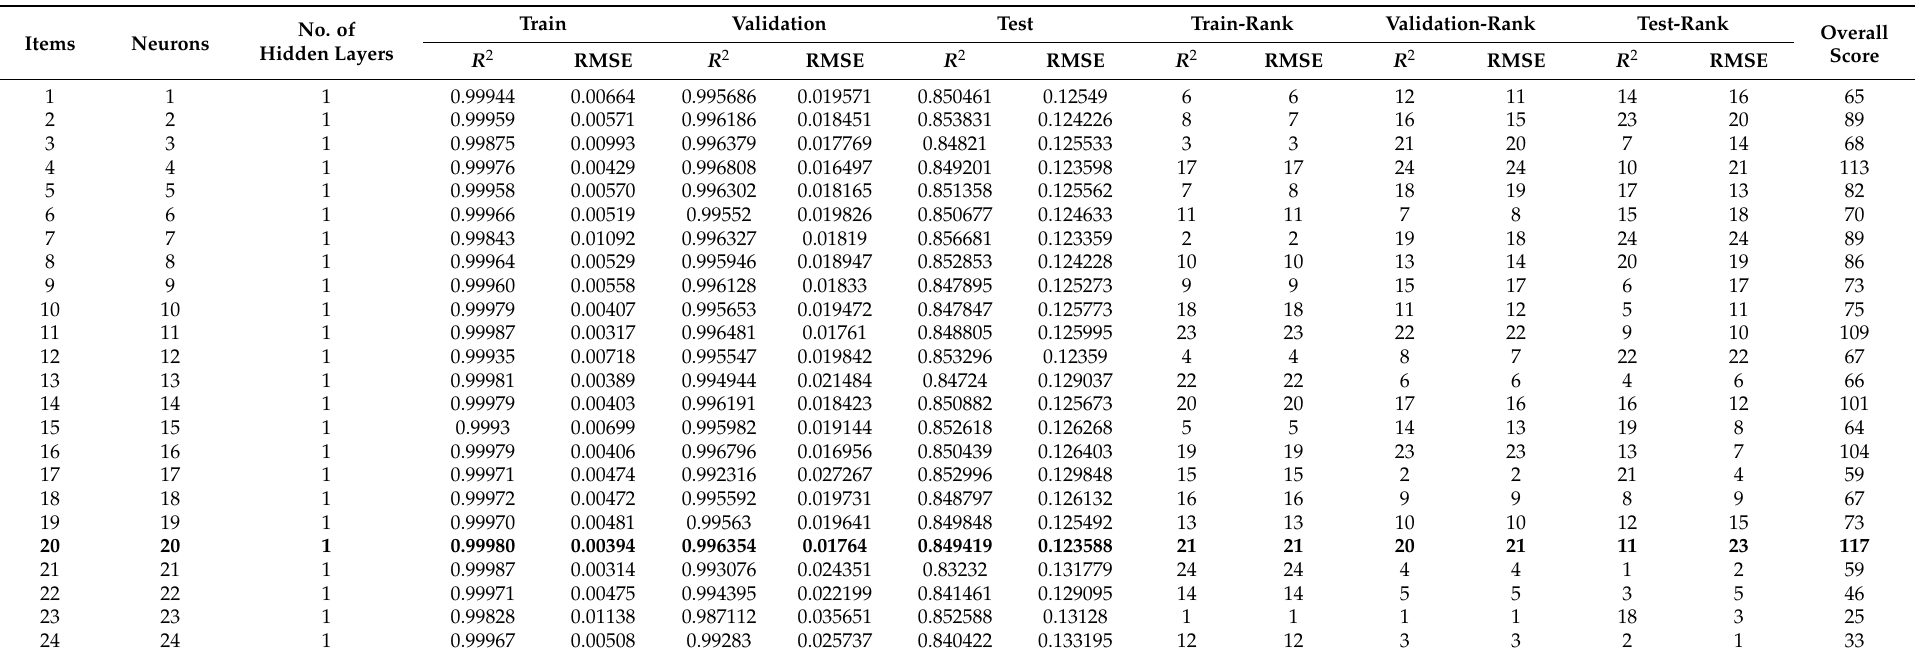
Table 3. Selecting the optimal ANN model with respect to single hidden layer and neurons for the USA dataset.